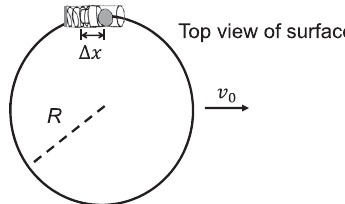
FIG. 9. The two versions of the simultaneous synthesis problem.